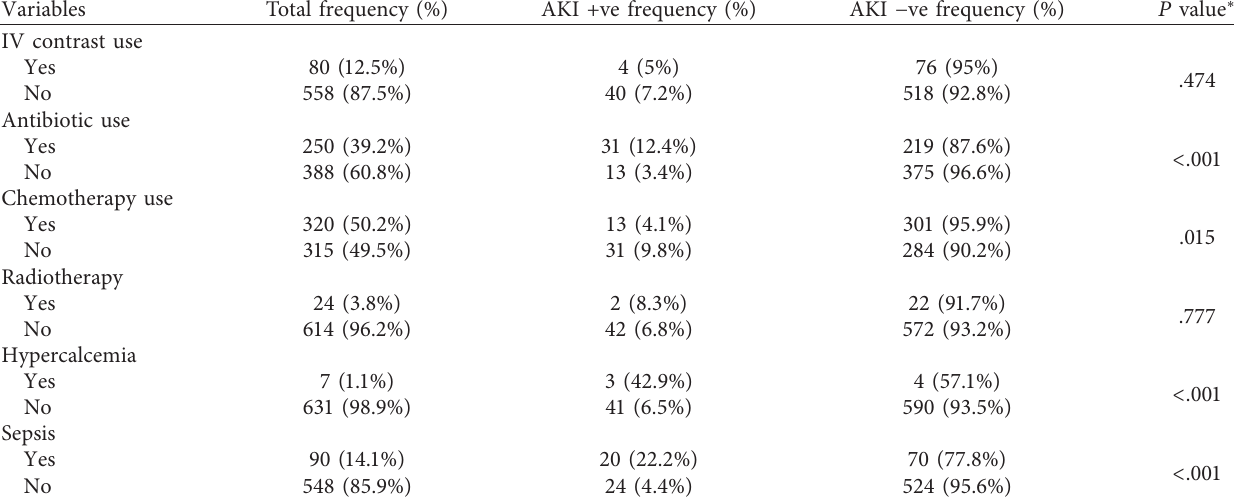
Table 2: Univariate analysis of AKI with clinical characteristics among cancer patients during admissions.